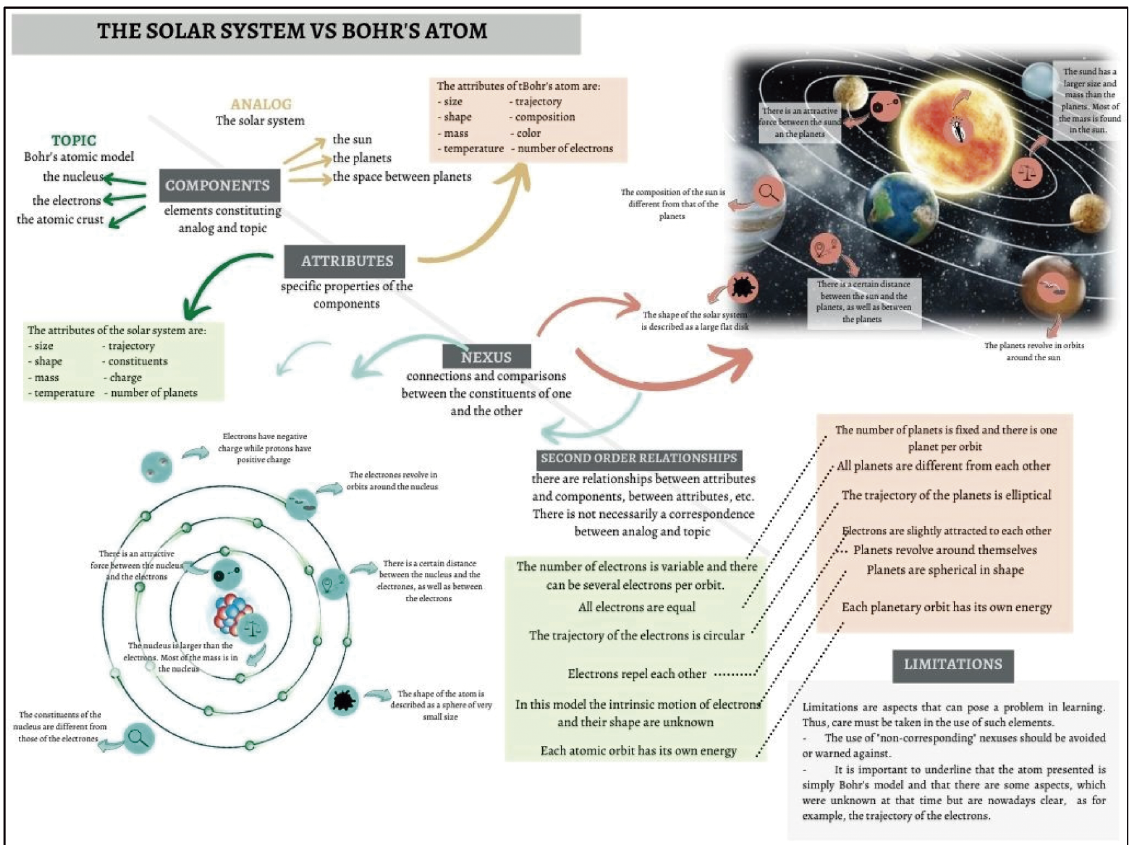
Figure 6. Infographic Solar System-Bohr